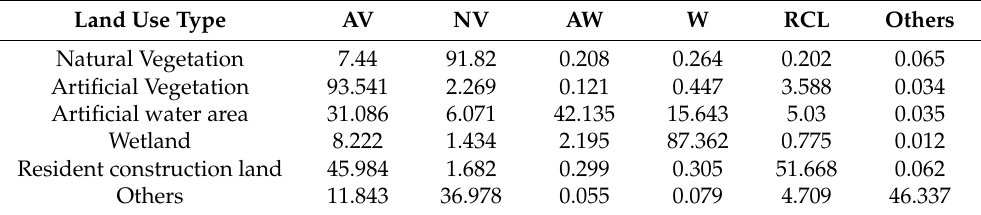
Table 4. The Huai River Basin’s land-use and land-cover transformation matrix from 1985 to 2014 (in